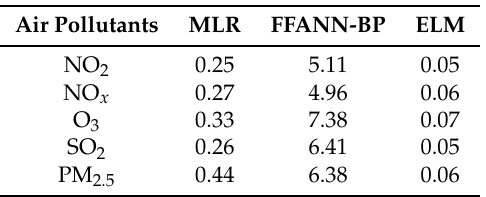
Table 3. The training time s of MLR, FFANN-BP, and ELM on the air pollutant O 3 with the size of the hidden layers 20 at Sham Shui Po.